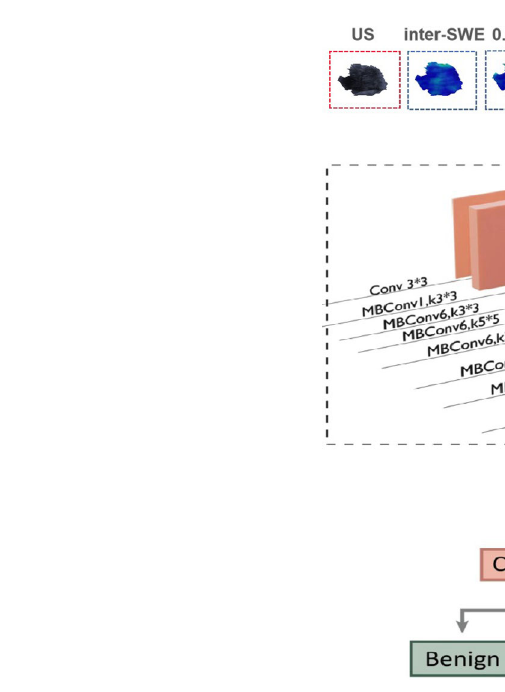
FIGURE 4 Network architecture of single prediction model for breast cancer. The input layer is a single US image or a segmented SWE